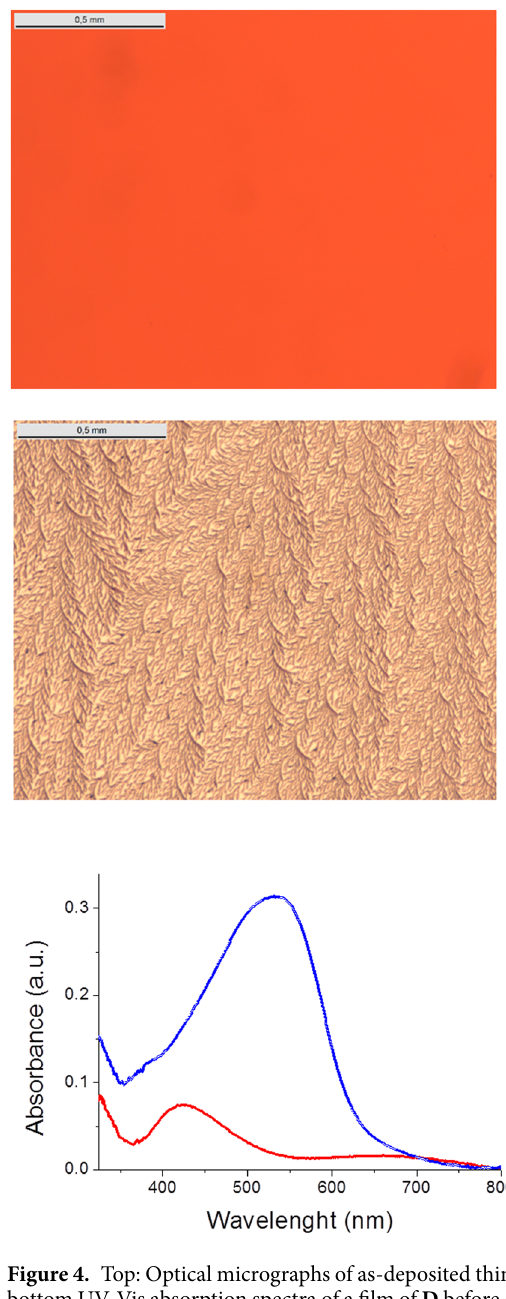
Figure 4. Top: Optical micrographs of as-deposited thin films of D ; middle same film after 10 min at 140 °C; bottom UV-Vis absorption spectra of a film of D before (blue) and after (red) ten minutes at 140